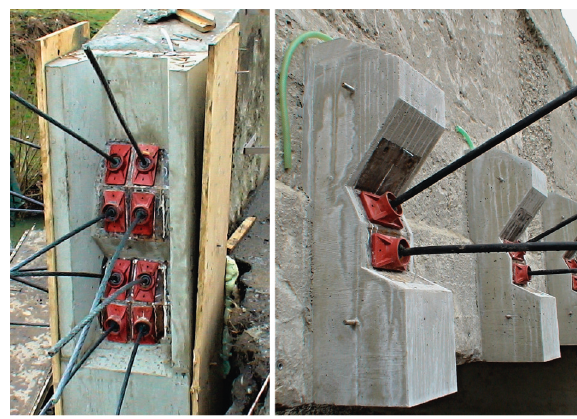
Figure 10: Realization of the additional anchorage areas of both main girders and cross girders. In this implementation, a new type of encapsulated single-strand anchors was used (2008). The an- chors are covered and protected in concrete extensions [23].